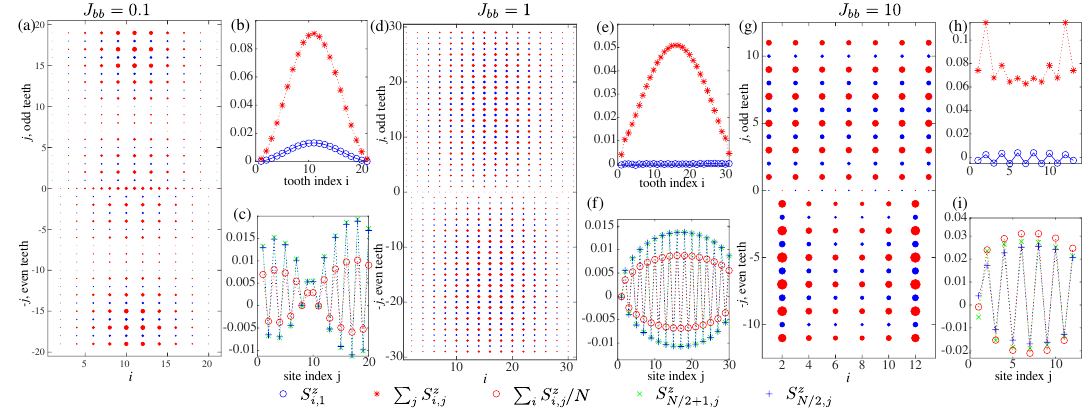
Figure 12: (Color online) Same as Fig.11 but for L -even and N -odd: (a)-(c) and L = 20, N = 21; (d)-(f) L = 30, N = 31; (g)-(i) L = 12, N = 13 -0.06-0.04-0.0200.020.040.06 Figure 13: (Color online) Local magnetization along a finite-size chain at various values of the coupling constant at the middle bond. (a) When the coupling is uniform along the chain, the magnetization profile has a butterfly shape. When the coupling on the middle bond is smaller, the double-butterfly structure emerges. The shape of the magnetization profile at each half chain - non symmetric butterfly - is similar to the profile observed in a